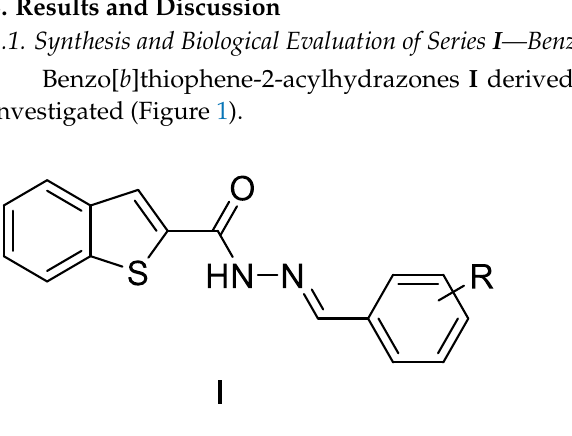
Figure 1. General structure of set I derivatives.